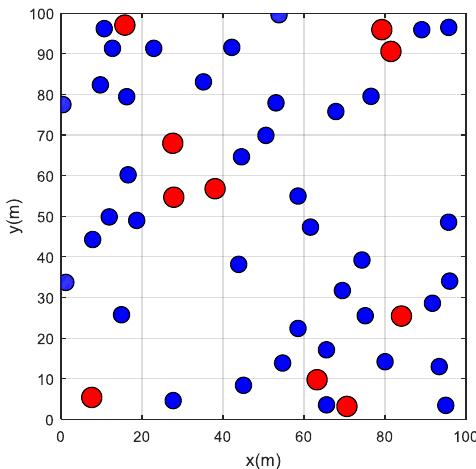
Figure 6. Plot of reference and target nodes for case 3. The obtained results along with the MSE for this case are tabulated in Table 3. It can be seen from this table that the MVPA was able to find the coordinates of all target points with good accuracy (less than 5 cm) except for two locations; at the same time, the remaining algorithms have struggled to do so. Moreover, the objective function minimized over the iterations is sketched in Figure Table 3. Comparison of actual locations with those obtained using different algorithms for case 3.